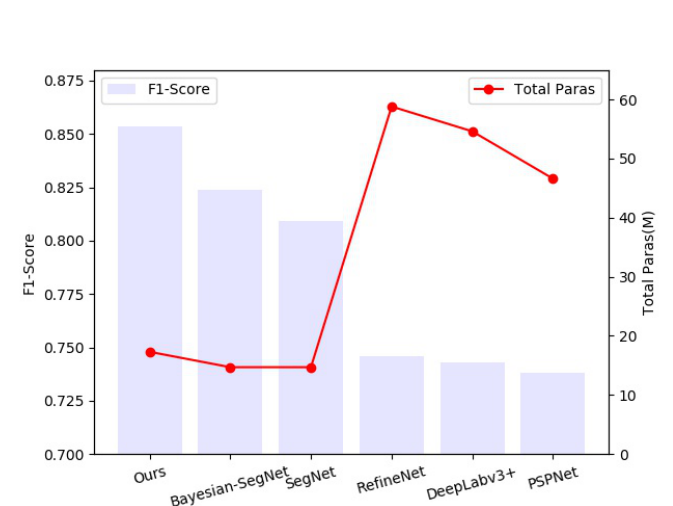
Figure 8. Segmentation accuracy and total parameters comparison of different networks. The bar diagram represents the F1-Scores evaluated on the Massachusetts Building Dataset and the line chart represents total parameters of different networks. The unit is Million (M).